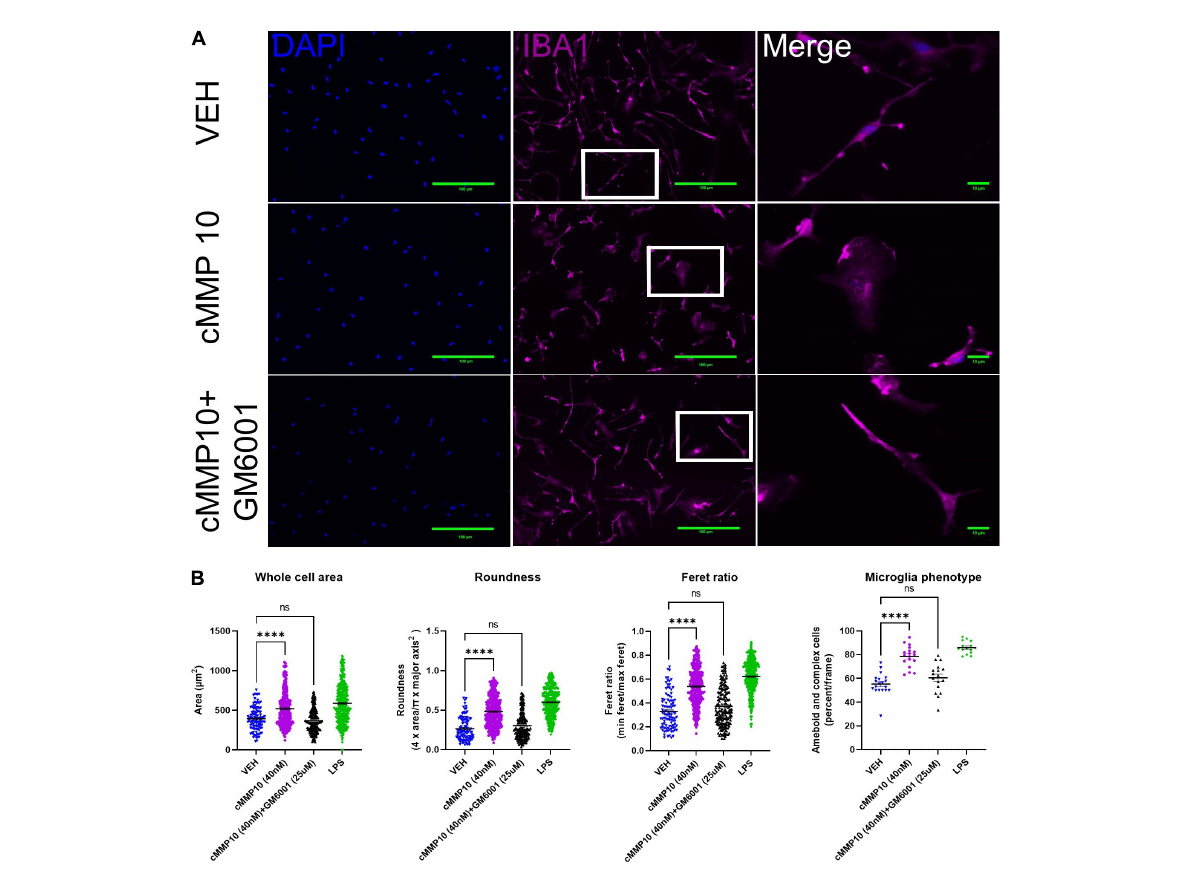
FIGURE3 cMMP10 induced morphology changes are reversed in microglia with the pan-MMP inhibitor GM6001. (A) Iba1 immunocytochemistry (magenta) was conducted on microglia to analyze cell morphology after exposure to 40 nM cMMP10 or vehicle (VEH) for 24 h. Microglia that are enlarged are indicated by the white box and are shown in the far-right column of each row. (B) Consistent with a visual change, cMMP10 exposure led to a change in morphological parameters such as whole cell area, roundness, and Feret ratio compared to vehicle treatment; VEH n = 103 cells, cMMP10 n = 340 cells, cMMP10 + GM6001 = 184 cells, and LPS = 360 cells. cMMP10 exposure also increased the percentage of proinflammatory microglia (ameboid or complex); VEH n = 19 images, cMMP10 n = 18 images, cMMP10 + GM6001 = 17 images, and LPS n = 15 images. Notably these changes are reversed by the pan-MMP10 inhibitor GM6001 (no significance compared to VEH). LPS was used as a positive control. Through the experiment was conducted with three technical replicates per treatment, values reported are the measurement from individual cells. When the average of each well is used to perform statistical analysis instead, the trend observed still holds. Values are reported as mean ± SEM; One-way ANOVA compared to VEH; Dunnett’s post-hoc test; ∗∗∗∗ P ≤